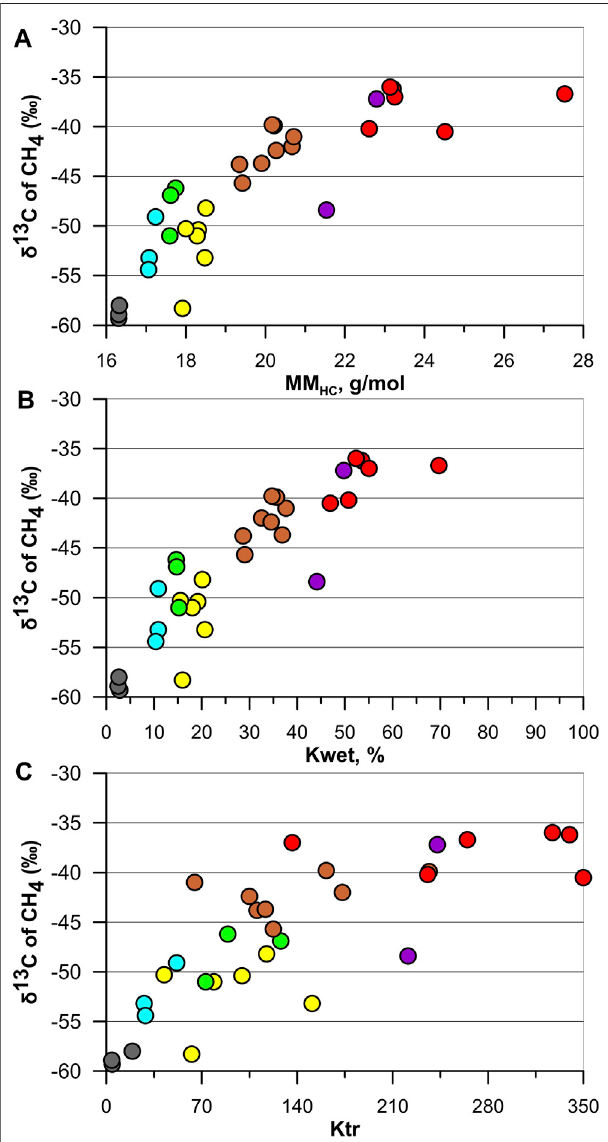
isotopicdata δ 13 C-CH 4 withMM HC (A) ,Kwet (B) ,and Ktr (C) . Genetic groups are the same such as in Figure 5